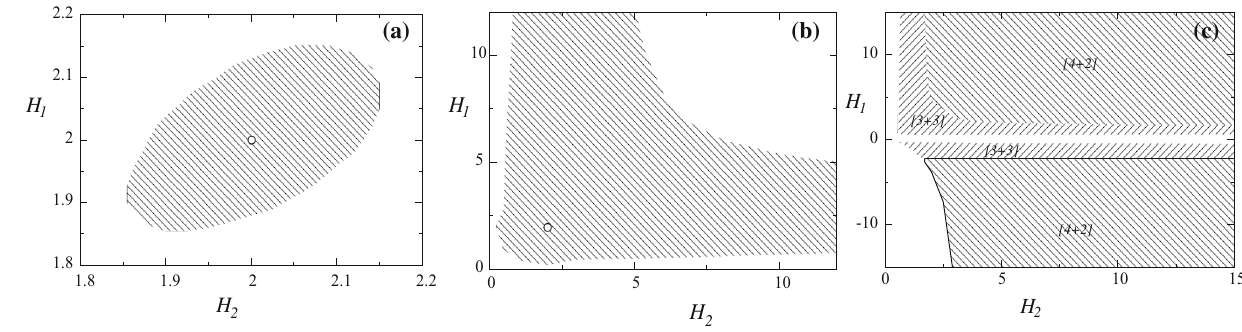
Fig. 1 Typical stability areas for vacuum K 3 → K 1 regime on a ; vacuum and (cid:2) -term K 3 → E 3 + 2 regime on b ; vacuum and (cid:2) -term K 3 → E 3 + 3 (and possibly higher number of extra dimensions as well) regime on c (see the text for more details)